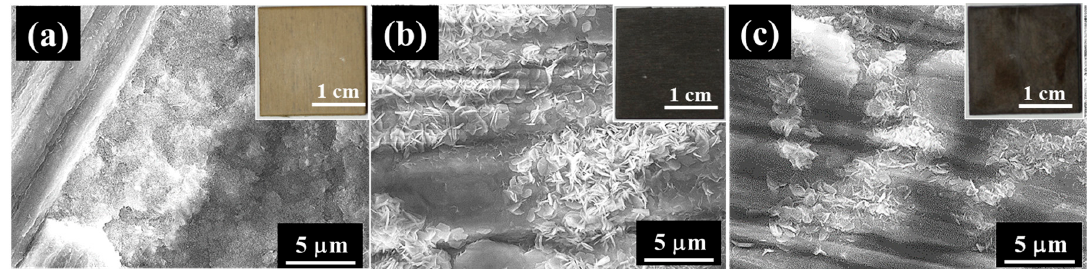
Figure 1. SEM images of films prepared at 423 K for 5 h on ( a ) AZ31, ( b ) AZ61, and ( c ) AZ91D. All insets show the appearance of the film surfaces.